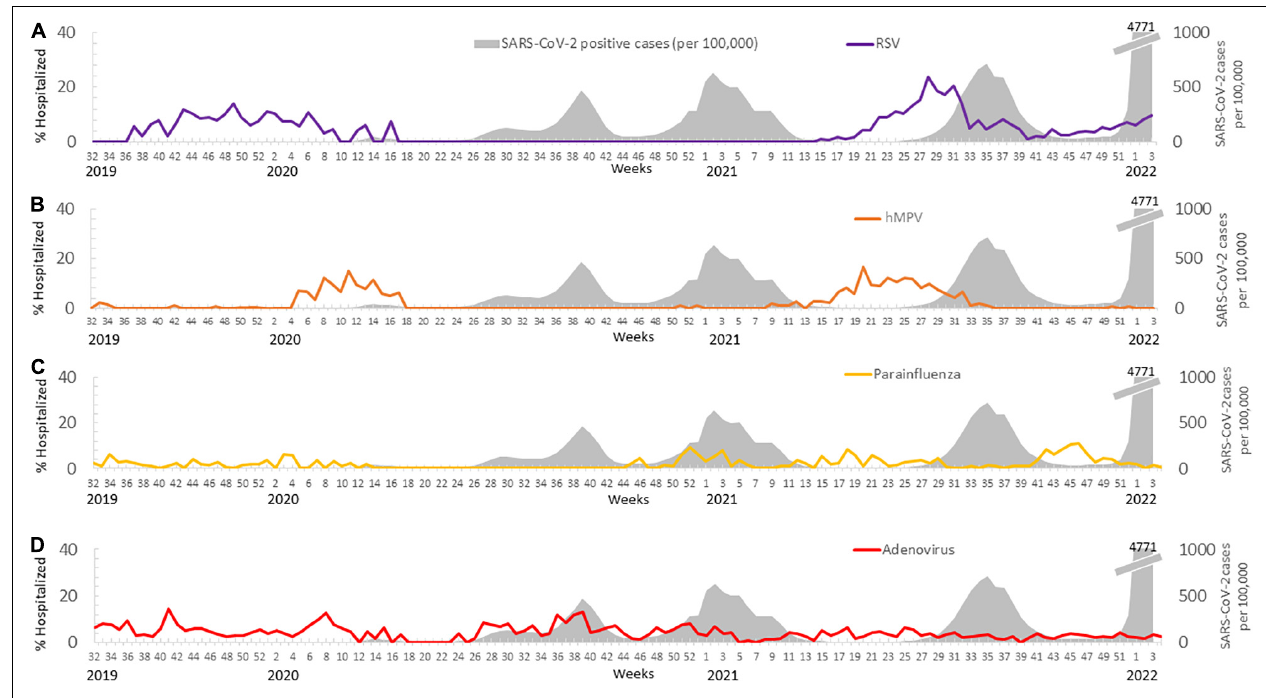
FIGURE 3 | The rate of cases carrying respiratory viruses detected before and during the SARS-CoV-2 pandemic. The percentage of hospitalized patients carrying RSV (A) , parainfluenza (B) , HMPV (C) , and adenovirus (D) during the various waves of the SARS-CoV-2 pandemic (in